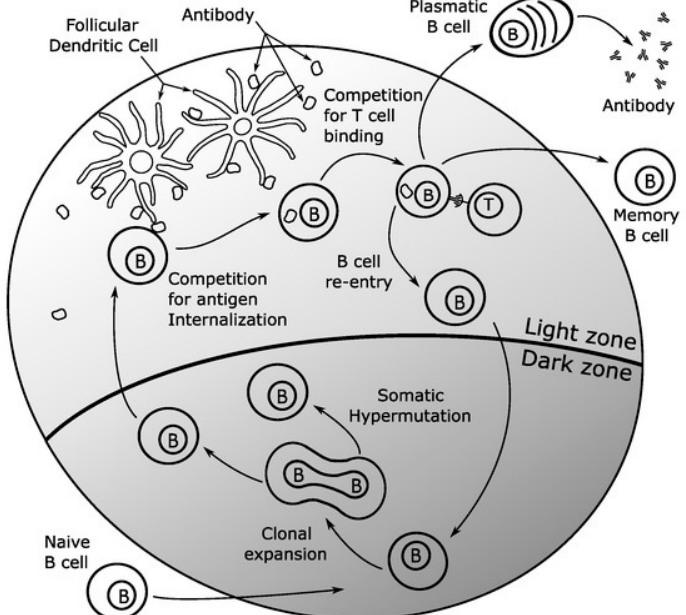
Figure 8. Illustration of the B cell generation in the germinal center [41].